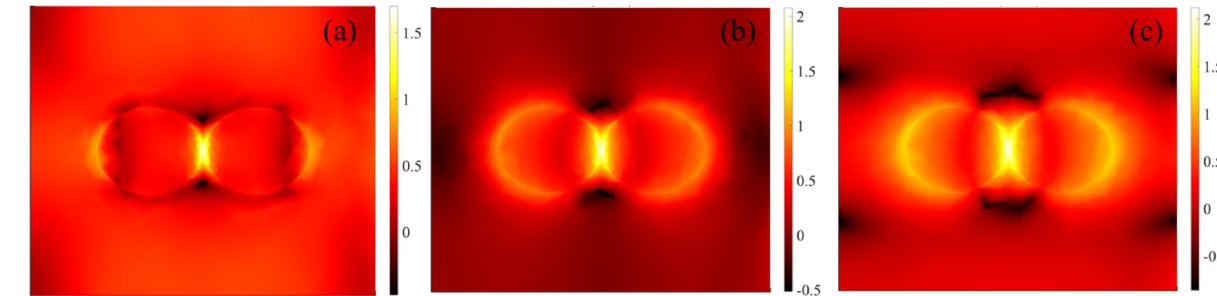
h i Þ FE ð ~ r ; l 1 across the unit cell, in the plane directly above the 10 a ; p ; s